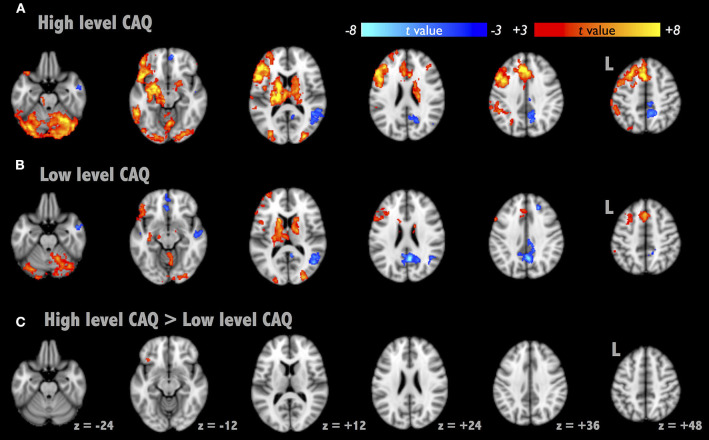
Brain activation maps of Alternative Uses Task (AUT). We presented the activation maps divided into two groups as follows: high- and low-creative [(A,B), respectively, segregated by CAQ scores]. (C) The AUT contrast map between the two groups, where the contrast region subsided in the left inferior frontal gyrus (BA 47).